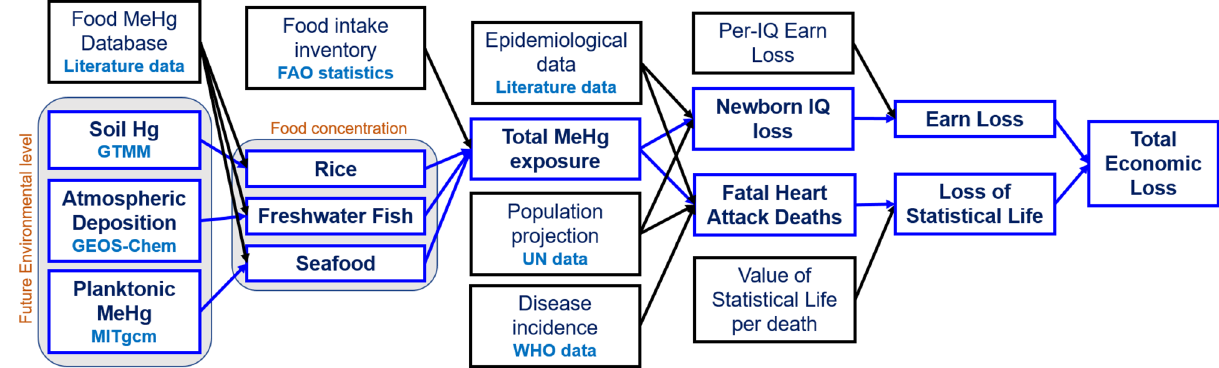
Fig. 7 Diagram for the approach and data sources for methylmercury exposure and risk calculation in this study. Blue frames represent model calculated variables, while black ones are for literature